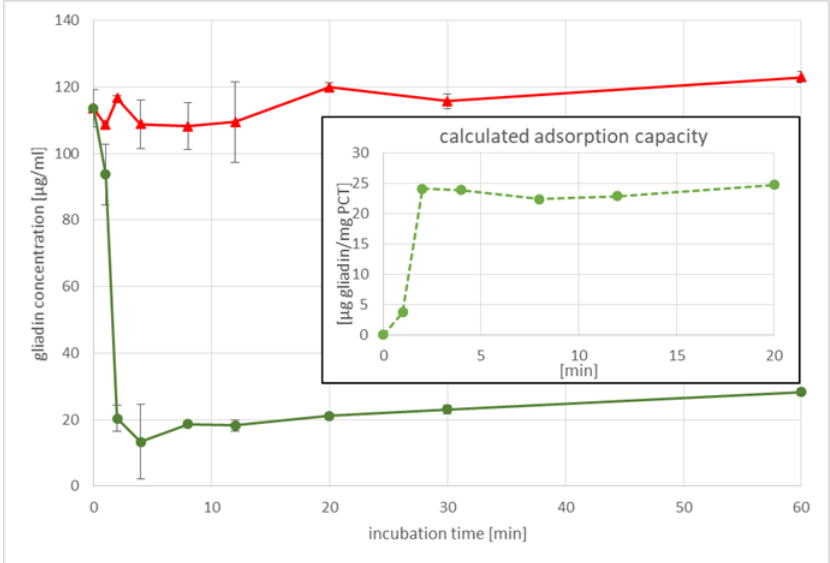
Figure 1. Incubation time versus gliadin concentration. A typical experiment is given. The red top line refers to the amount of gliadin in controls, while the bottom line in green shows the decline of gliadin in the supernatants in a time-dependent manner. Standard deviations are depicted for each time point and curve. In addition, the corresponding adsorption capacity is given by the dashed light green line (inserted diagram).